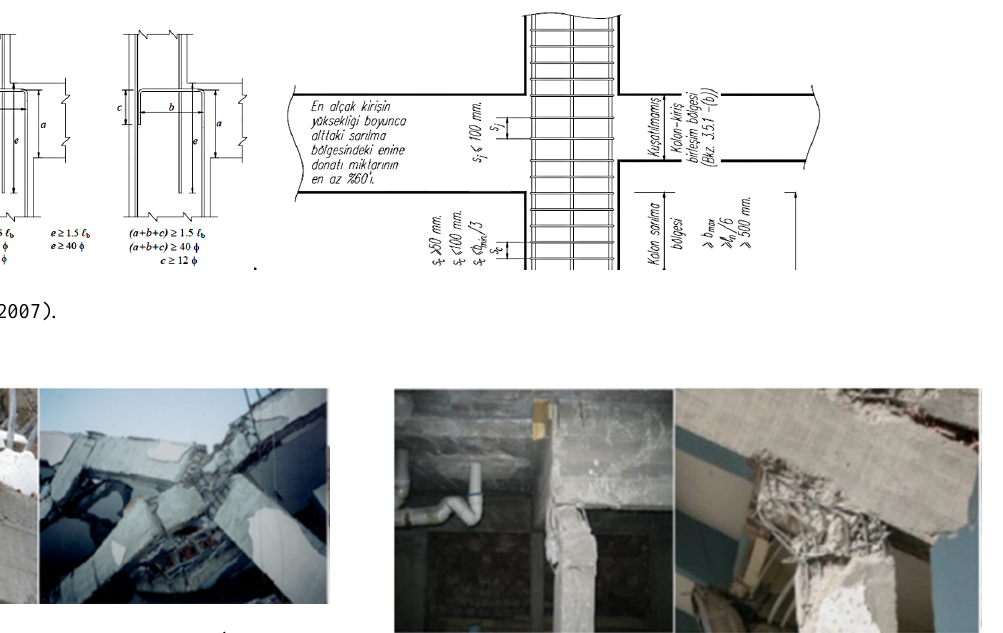
Figure 16. Damage to column–beam joint region (Onen et al., 2011).